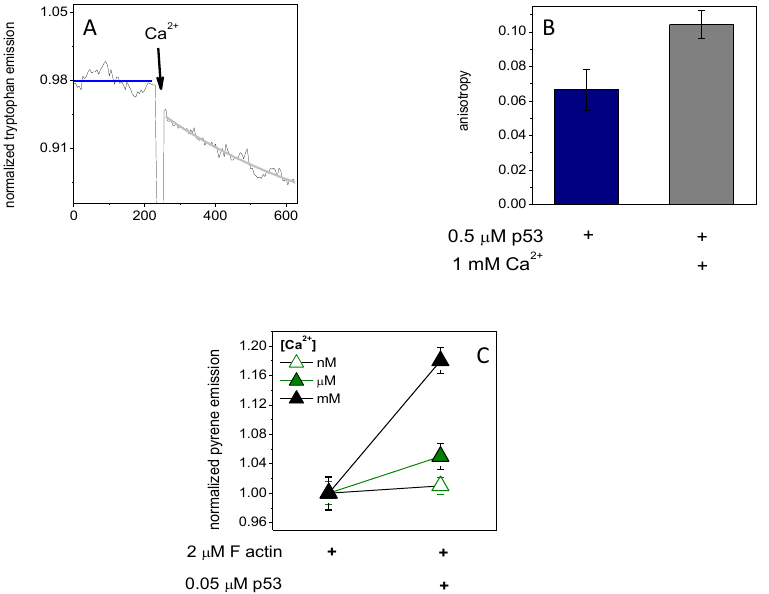
Figure 1. The intrinsic tryptophan fluorescence emission and anisotropy of p53 tumor suppressor factors were changed by Ca 2+ addition, and Ca 2+ helps p53 binding to actin. ( a ) The intrinsic tryptophan fluorescence emission of p53 (0.5 μ M) was decreased by millimolar Ca 2+ addition and ( b ) the steady-state anisotropy was increased. ( c ) The fluorescence emission of pyrene-labeled actin (2 μ M, 5% labeled by pyrene) under polymerizing conditions (100 mM KCl, 1 mM MgCl 2 ) in the presence of micromolar (green, closed triangle) then millimolar (black, closed triangle) Ca 2+ was increased by p53 (0.05 μ M), which could not be observed in the presence of nanomolar (open green triangle) Ca 2+ . The data presented were derived from at least three independent experiments. Values are displayed as the mean ± standard deviation.